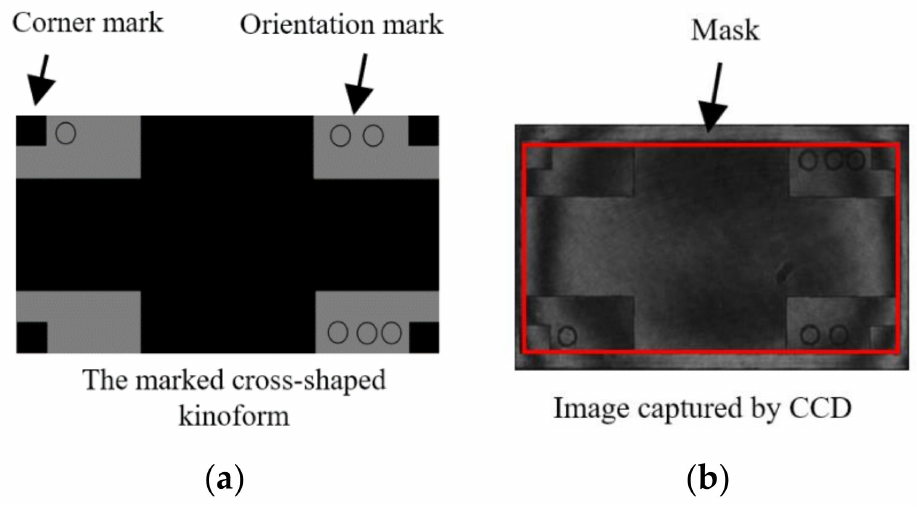
Figure 7. Mask matching procedure using a marked cross-shaped kinoform ( a ) to get the image ( b ). The total phase modulation depth of the LCoS-SLM is limited to 2 π , for the benefit of phase-unwrapping algorithm used in the interferometer software. Therefore, the LcoS- SLM has a 2 π phase encoded in 146 levels with a “5-5” electrical addressing sequence configuration, which is shown in Figure 8a. The sequence “5-5” means the duty cycle of the LcoS-SLM driving voltage, which makes the liquid crystal molecules tilted to modify the phase of the extraordinary light. Typical flicker of 5-5 configuration is shown in Figure